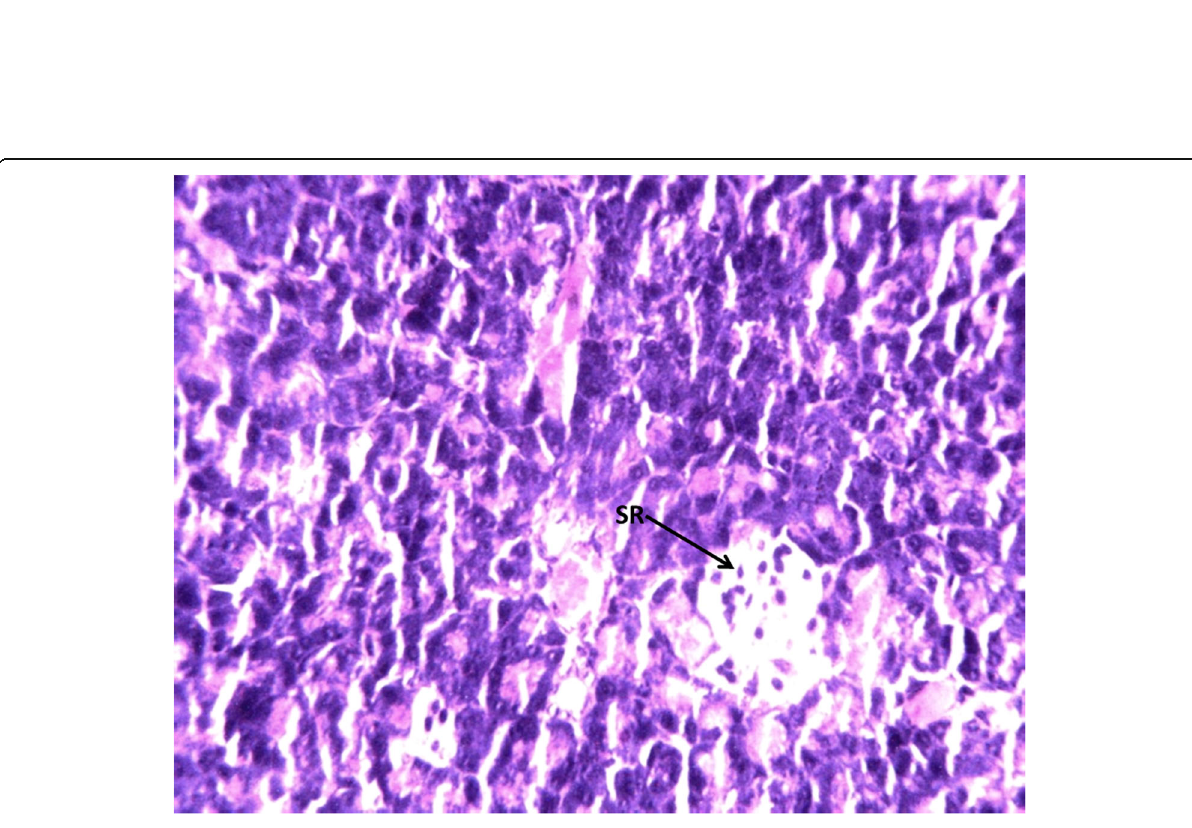
Fig. 2 Histology of the pancreas section stained with hematoxylin and eosin in the group treated with 1000 mg/kg of aqueous stem bark extract of P. macrophylla , × 250. SR, slightly restored pancreatic islet